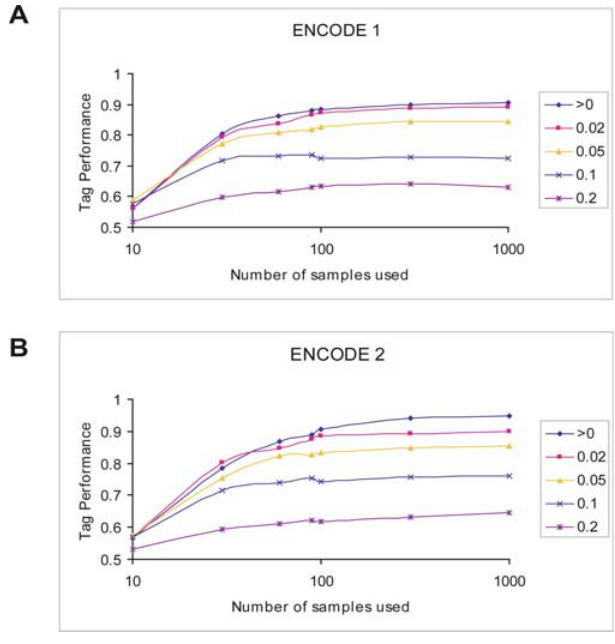
Figure 7. Effect of Sample Size on Tagging Performance Random sets of 10, 30, 60, 100, 300, and 1,000 EGP samples were used to select tags at different MAF thresholds (shown as different colored lines). Tags were then tested in the CEU population, and the ratio of tagged versus all polymorphic SNPs (using an r 2 threshold of 0.8) was plotted for (A) the ENCODE 1 region and (B) the ENCODE 2 region. An average of 100 tests is shown. DOI: